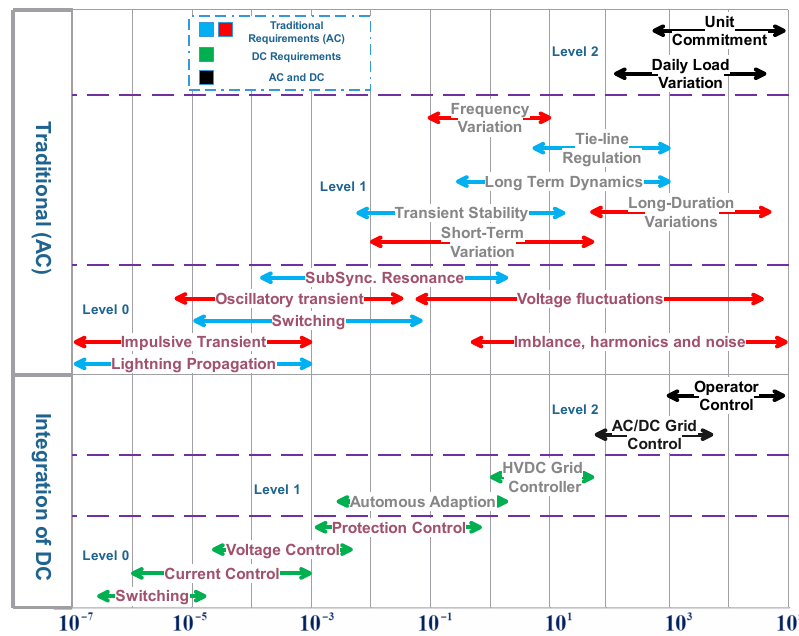
Figure 2. Different operation/control timescales in an AC/DC power